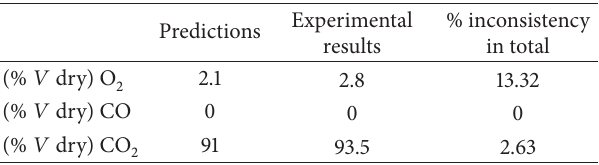
Table 4: The measured and predicted amount of volume percent- ages (dry basis) of O 2 , CO 2 , and CO at the exhaust.